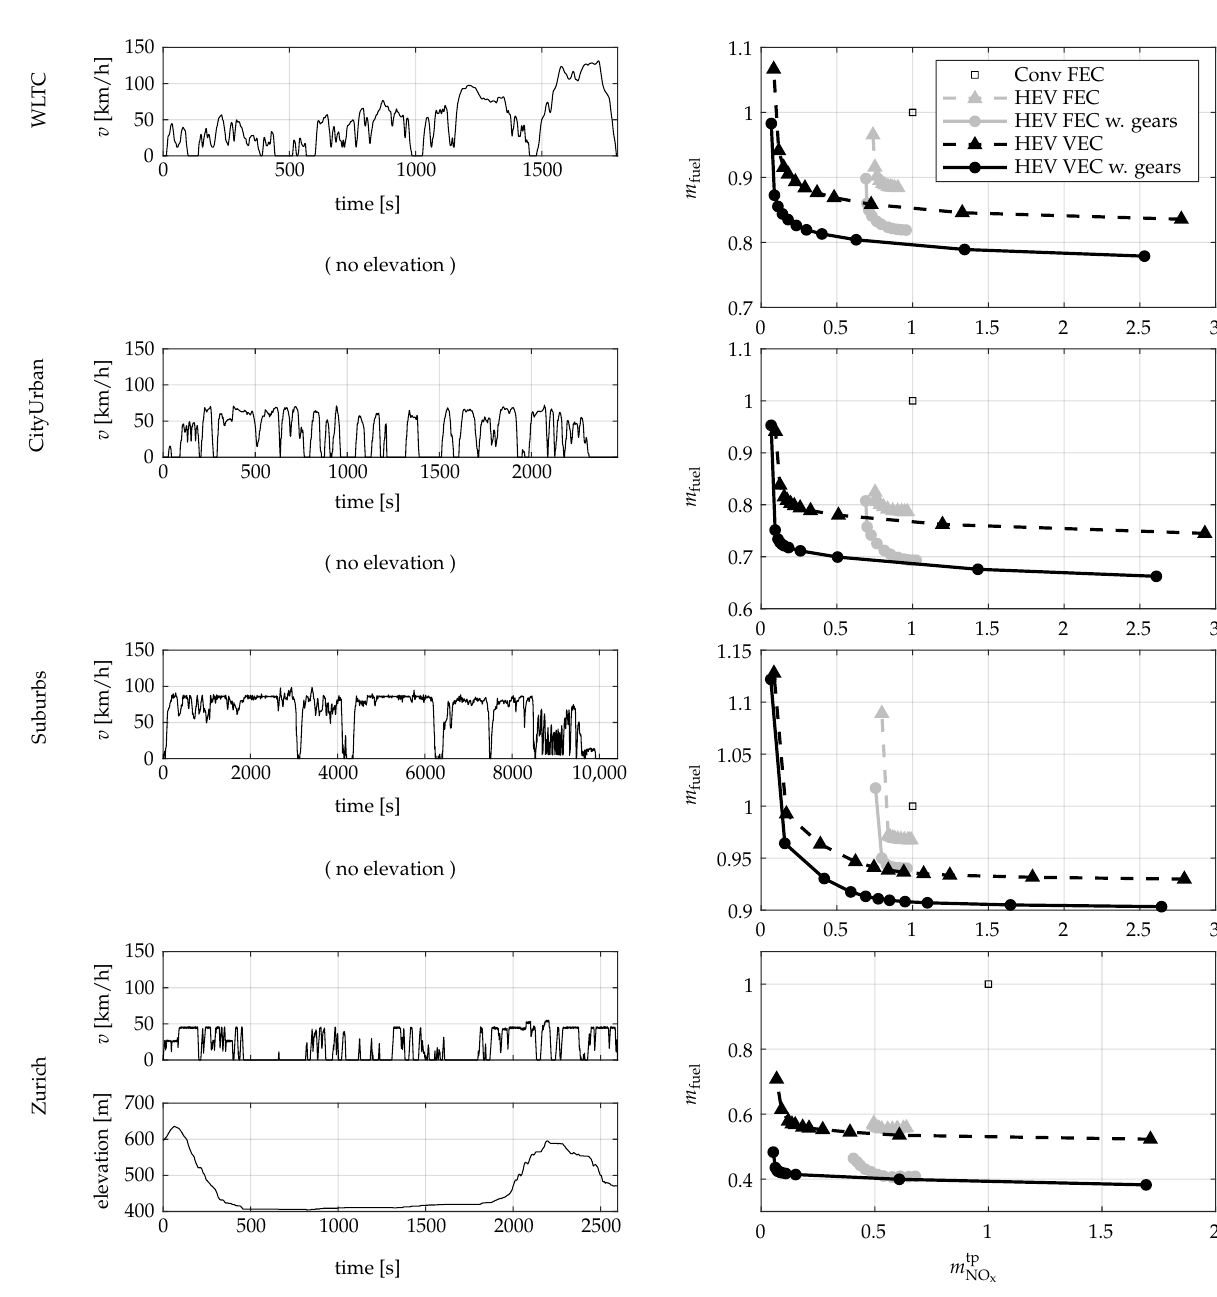
Figure 13. Optimal operation of an HEV. The driving missions are shown on the left, and the resulting trade-offs between fuel consumption and emitted NO x are shown on the right. An initial ATS temperature below the light-off temperature was used for all driving missions. All values were